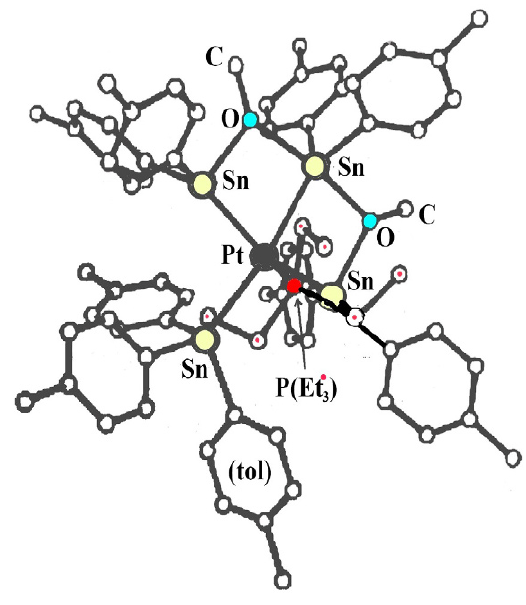
Figure 4. Structure of [(PEt